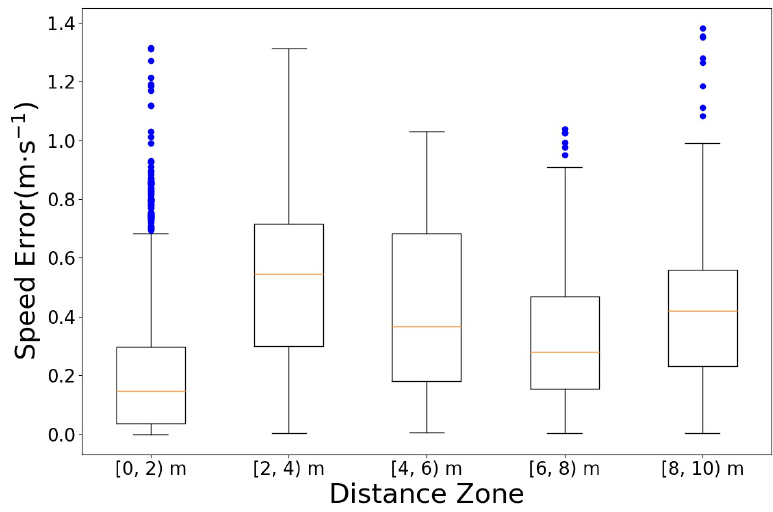
Figure 27. Speed error boxplot by distance zones: comparison with Vicon